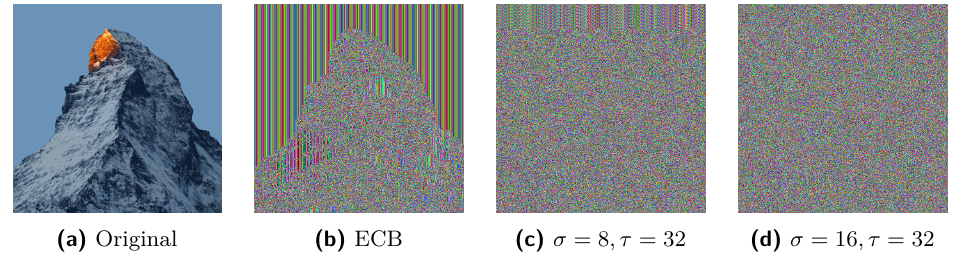
Figure 7: Visualization of the impact of the security parameter σ . A 512 × 512 image of Matterhorn (Figure 7a) has been encrypted with K = thisisasecretkey 2 using 1 , K 2 ECB [ AES-128 ] (Figure 7b) and SCB [ AES-128 , [ · ] τ ◦ SHA-256 ] for κ = n = 128, σ = 8 , 16, and τ = 32 (Figures 7c and 7d). The value chosen for τ guarantees perfect correctness. But clearly, both the ECB encrypted image and the SCB encrypted image with σ = 8 (note the repeating patterns in the top part) do not look pseudo-random, only the one encrypted with σ = 16 does. In fact, β = 512 × 512 × 3 ÷ 16 = 49 152 ≤ 2 σ only for σ = 16.